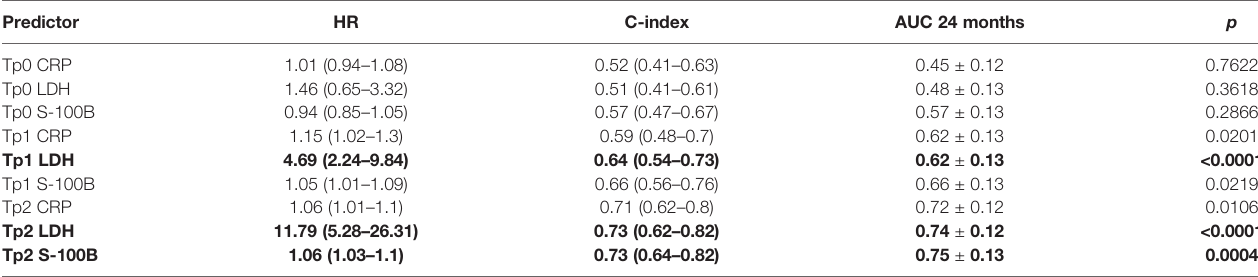
TABLE 4 | Results from univariate Cox proportional hazard regression on blood biomarkers with hazard ratio (HR), C-index, AUC at 24 months and p -values. Parameters statistically signi fi cant at FWER=0.05 are in bold. Predictor